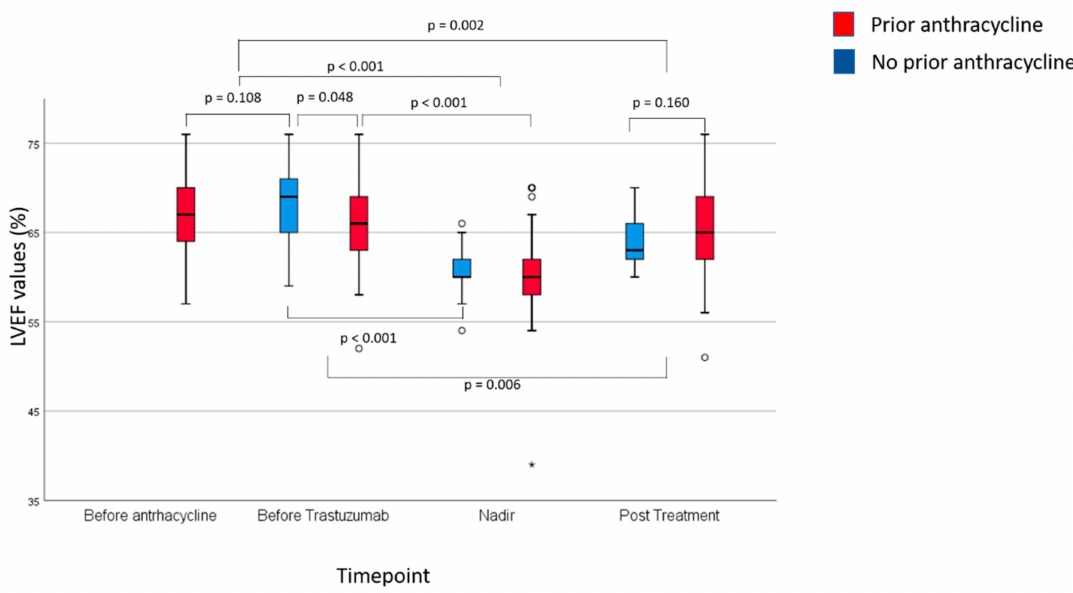
Figure 1. Summary of LVEF findings at baseline, LVEF nadir, and post-treatment according to prior exposure to anthracycline. The box extends from the 25th to the 75th percentile. The line is the median LVEF value. The lines extend to the largest and smallest observed values within 1.5 box lengths; “o” symbols represent outliers (values between 1.5 to 3 box lengths from the upper or lower edge of the box), asterisks represent extreme values (values of more than 3 box lengths from the upper or lower edge of the